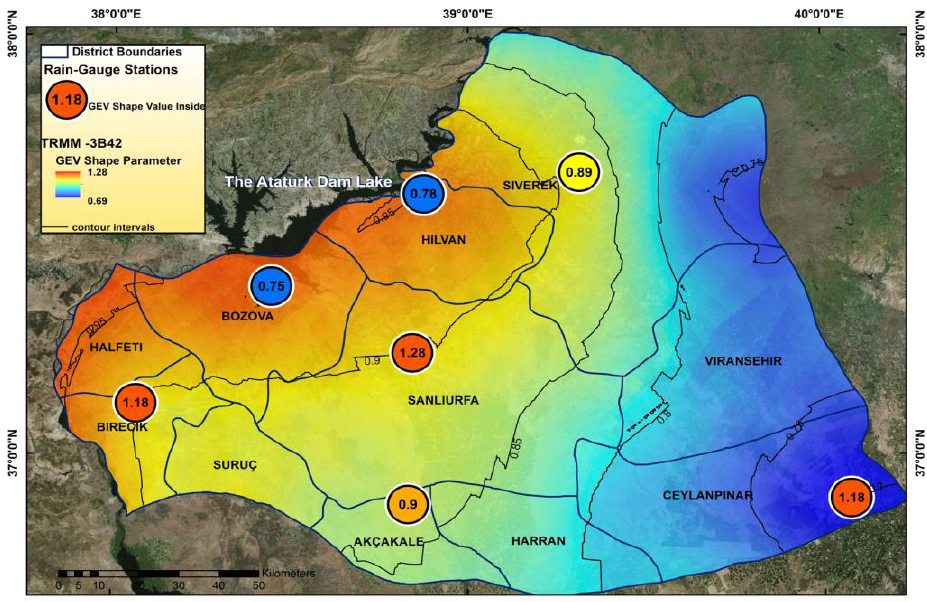
Fig 6. Spatial distribution of the GEV shape parameter for rain gauges (circles) and TRMM 3B42 for the period of 1998 to